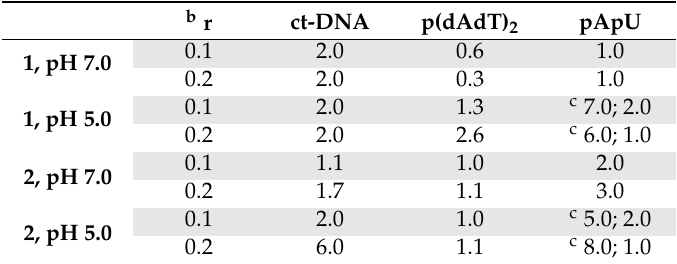
Table 1. ∆ T m -Values a ( ◦ C) for di ff erent ratios b r of 1 and 2 added to polynucleotide. b r ct-DNA p(dAdT) 2